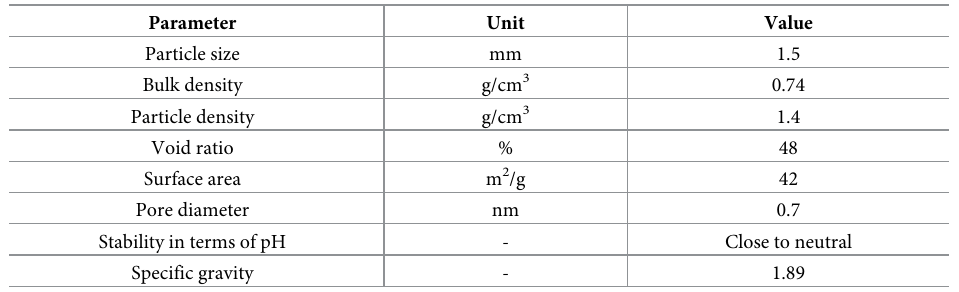
Table 2. Physicochemical properties of the zeolite material